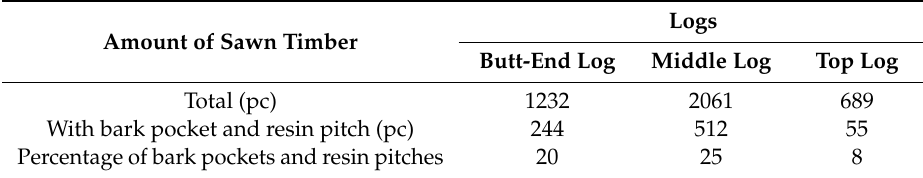
Table 16. The percentage of bark pockets and resin pitches as a factor a ff ecting the quality class of sawn timber in the longitudinal section of long logs. Logs Amount of Sawn Timber Butt-End Log Middle Log Top Log Total (pc) 1232 With bark pocket and resin pitch (pc) 244 512 55 Percentage of bark pockets and resin pitches 20